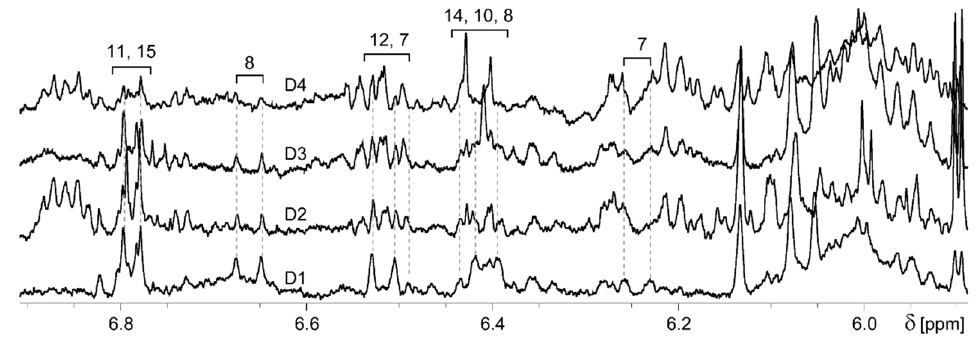
Figure 3. Comparison of the 6.9–5.5 ppm region of 1 H NMR spectra of the acetone extracts of salmon hepatocytes incubated with 13 C ‐ enriched astaxanthin for 48 h. D1, D2, D3 and D4–samples from diet 1, 2, 3 and 4, respectively. The numbers over the spectra show the 13C ‐ Ax resonance assignment. δ — chemical shift in ppm.